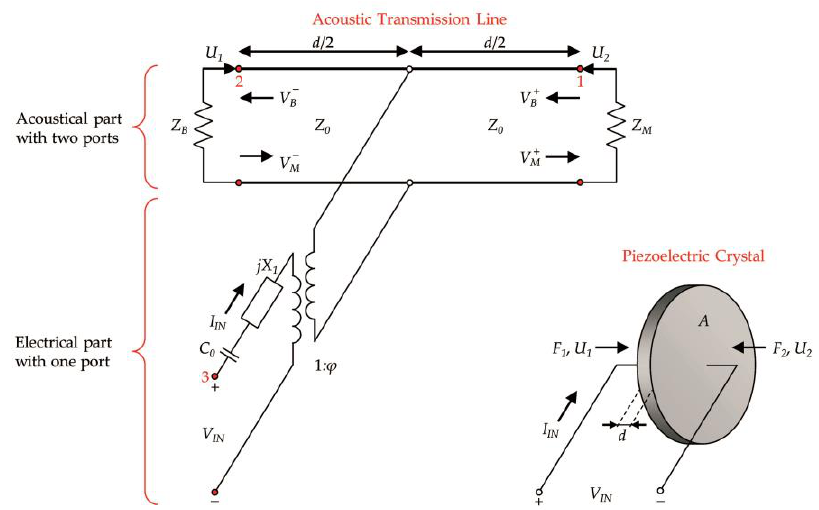
Figure 17. Schematic diagram of the Krimholtz–Leedom–Matthaei (KLM) model of a piezoelectric transducer.